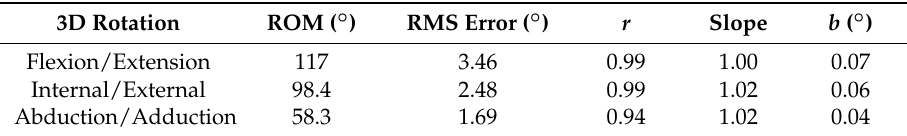
Table 2. Quantitative comparisons for the combined 3D rotation trial including range of motion (ROM), RMS error, correlation ( r ), slope and y-intercept ( b ) of linear